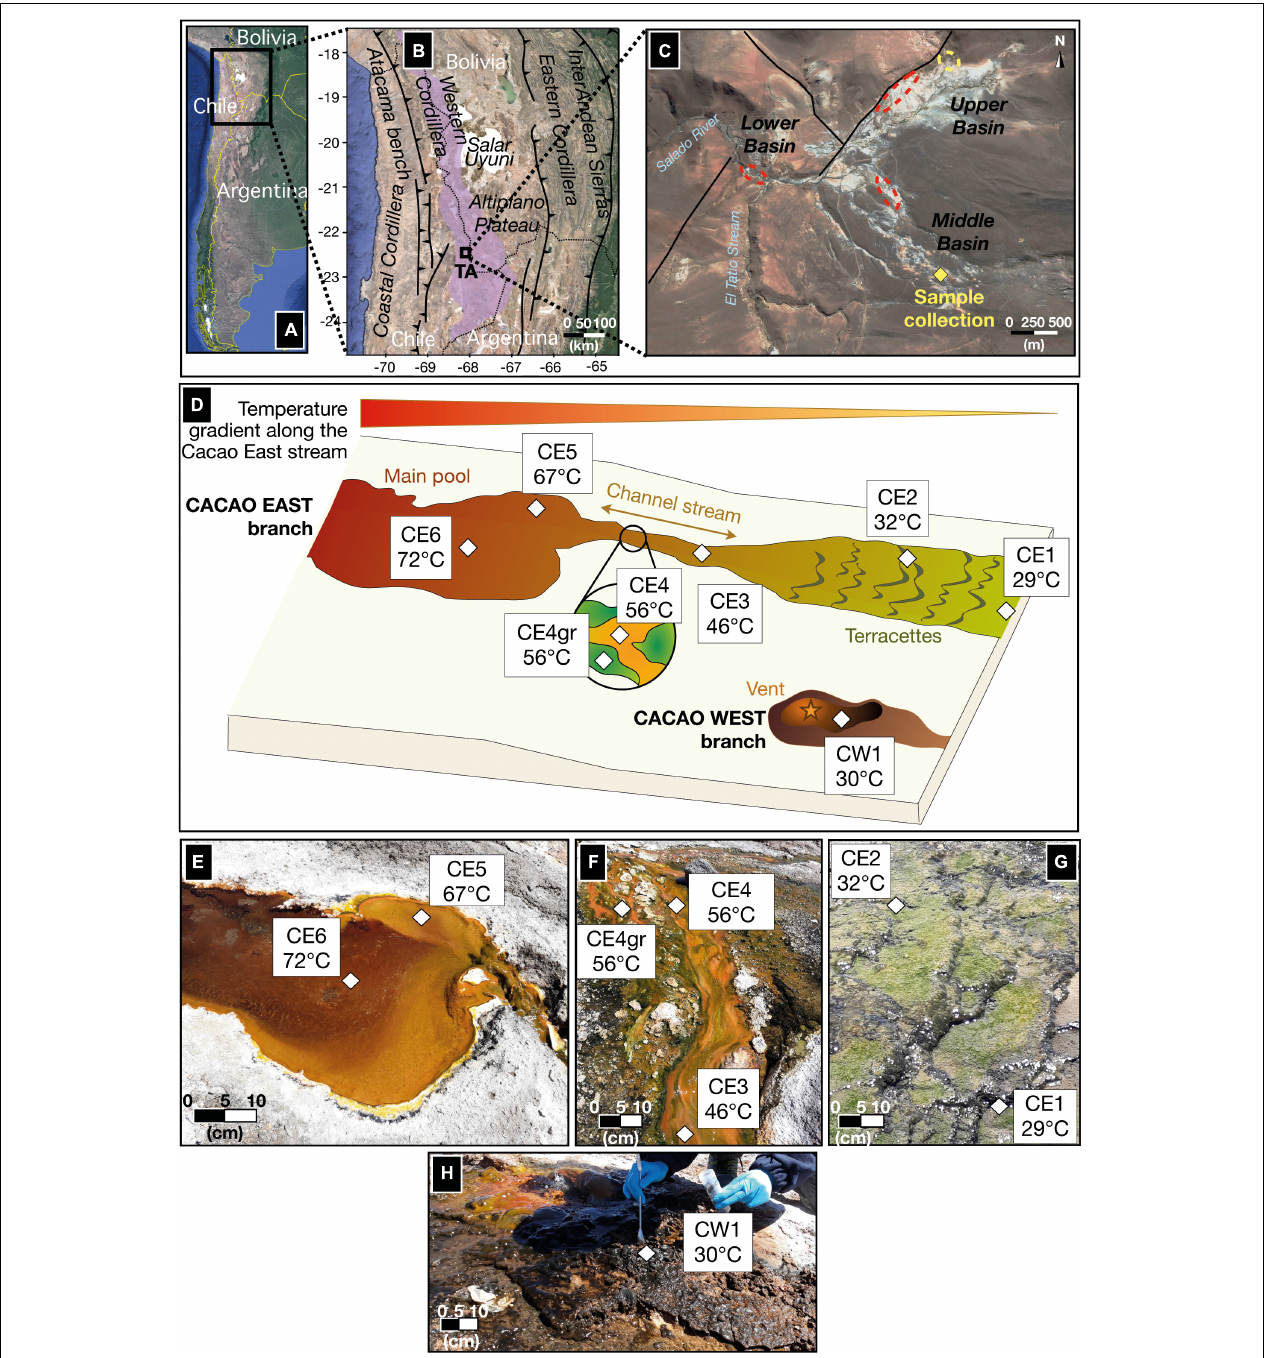
FIGURE 1 | A study site and a sampling area along the Cacao hydrothermal stream in the geothermal region of El Tatio. (A) Location of the El Tatio geyser field in northern Chile; (B) the black rectangle zooms in the Chilean Altiplano, where the Andean modern volcanic arc (a.k.a. Altiplano-Puna Volcanic Complex or APVC) is located (the purple area). The regional fault system, corresponding to sectors of contractional tectonics, makes the APVC a very highly uplifted area, explaining the high elevation of the El Tatio (TA) area (Lucchi et al., 2009). (C) The black square marked TA represents the inset view of El Tatio as a Google Earth image, showing the three basins, comprising the hydrothermal system (modified from Muñoz-Saez et al., 2018) and the location of the Cacao stream (yellow diamond), where the eight biofilm samples were collected. Local faults (black lines) allow hydrothermal circulations and explain part of the repartition of the primary areas with geysers and spouters (red dashed circles) or mud pools and volcanoes (yellow dashed circles). (D) A sketch of the hydrothermal transect (from 72 ◦ C to 29 ◦ C) studied along the Cacao stream, with seven biofilm samples collected from the East branch (CE) and one from the West branch (CW). (E–(H) a close view of the seven CE biofilms along the Cacao stream; (E) the vent pool, (F) the mid-apron channel, and (G) distal-apron terracetes . (H) A close view of the eighth biofilm (CW1) collected from the West branch of the Cacao stream.